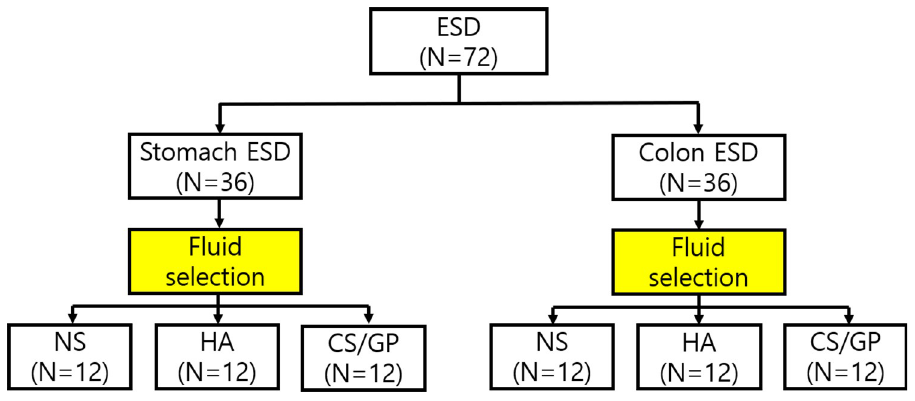
Fig 1. Schematic flow chart of